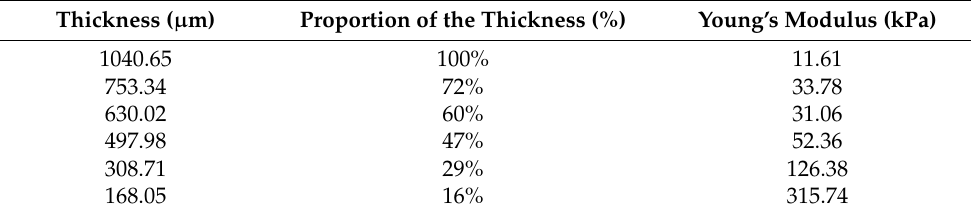
Figure 6. The OCT image of the porcine cornea. ( a – f ) OCT image of the same cornea with six different thicknesses, respectively. Table 1. Physical parameters of the